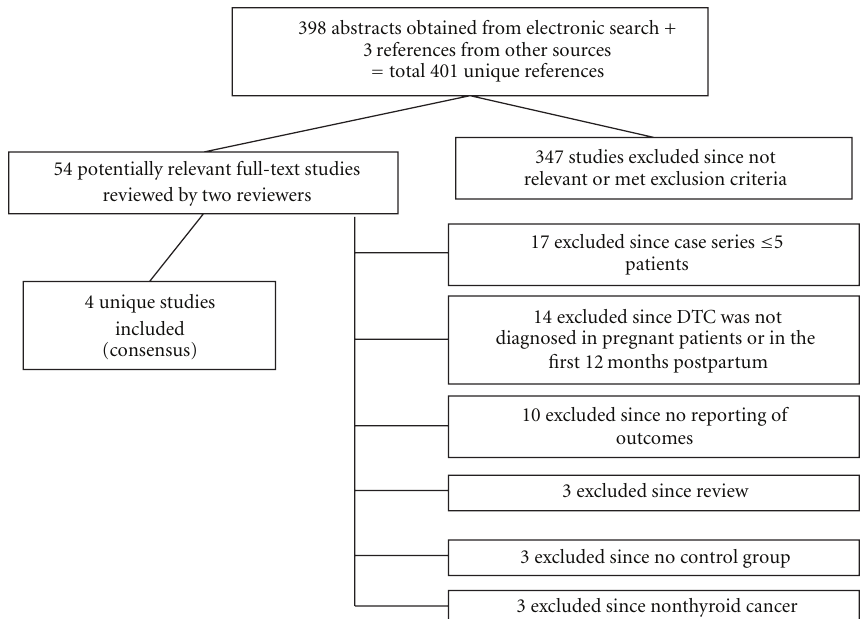
Figure 1: Process of study selection for the systematic